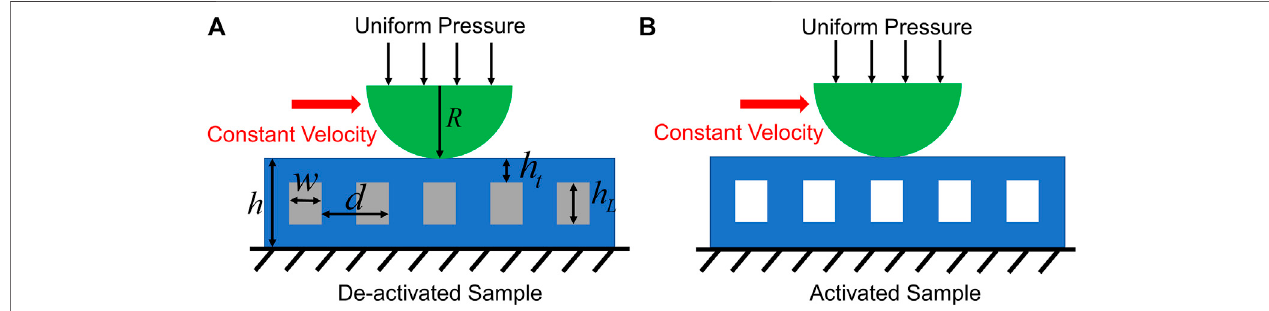
FIGURE 6 | Schematic illustration of the geometry model in ABAQUS for deactivated (A) and activated (B) composite pad sample. The geometric parameters are R (cid:1) 1.585 mm, h (cid:1) 1.2 mm, w (cid:1) 0.2 mm, d (cid:1) 0.8 mm, h L (cid:1) 0.5 mm, and h t (cid:1) 0.4 mm.